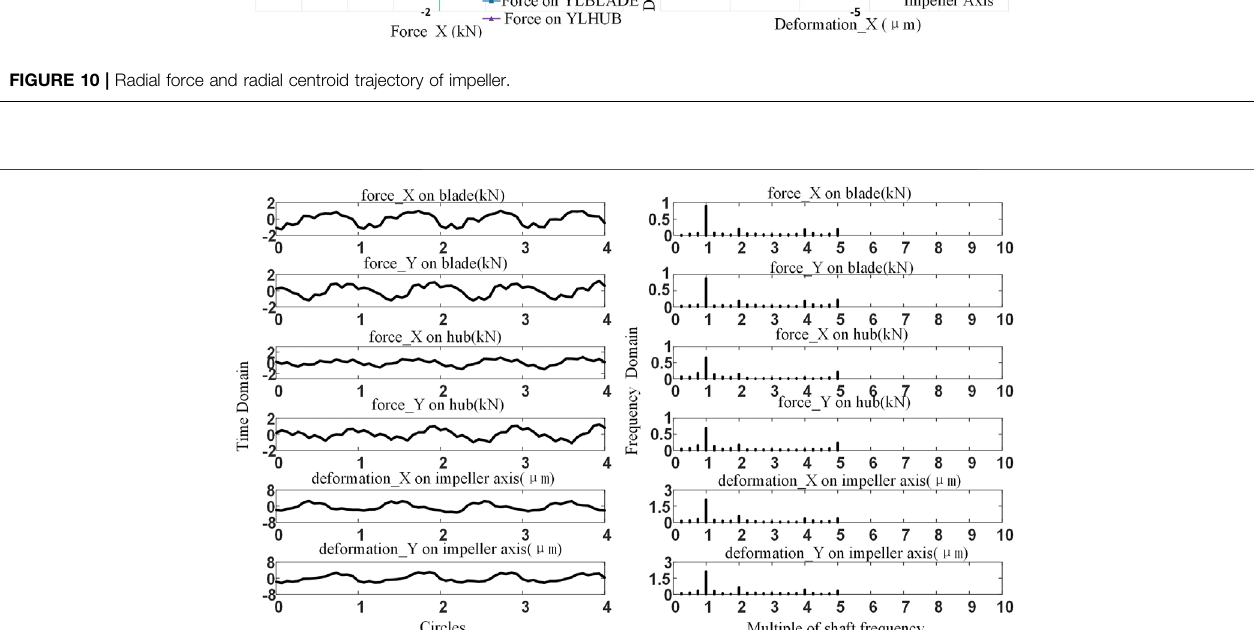
FIGURE 11 | Time and frequency domain diagram of the impeller radial force and axial